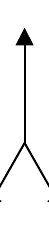
Figure 7. Cogging torque verification of proposed method by FEM: ( a ) each group ( b ) sum compar- ison.